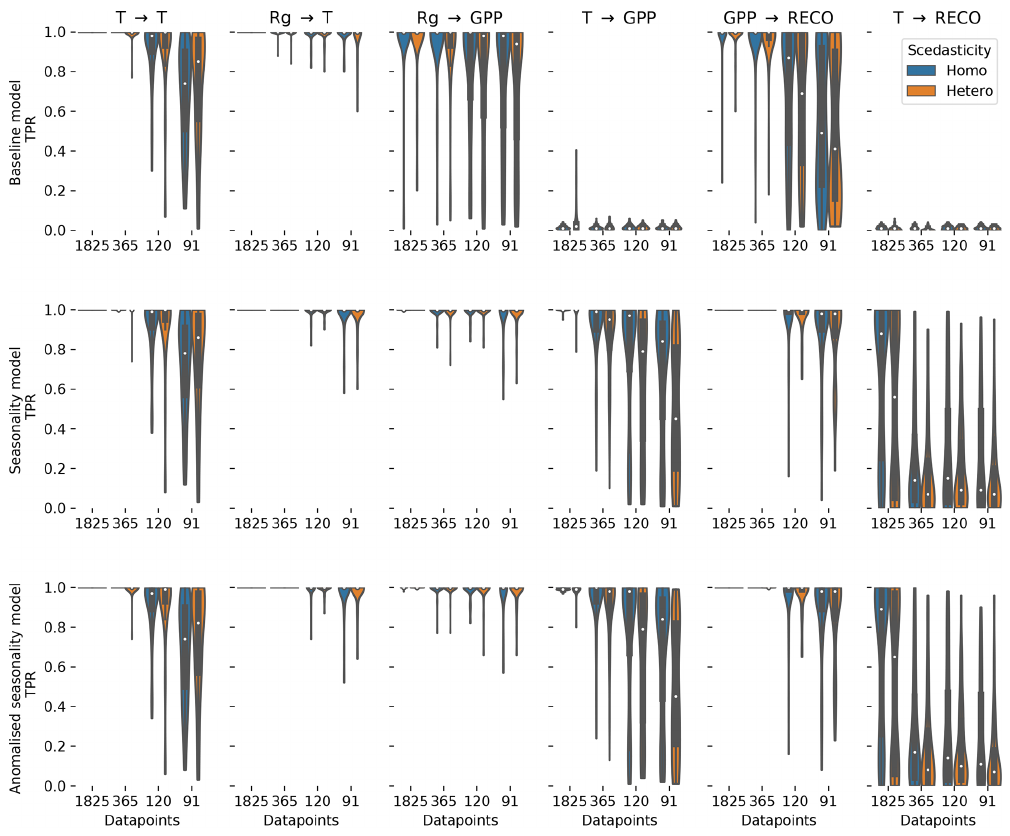
Figure 3. The distribution of the true positive detection rates for each link in the test model estimated for the baseline dataset, the season- ality dataset, and the anomalised seasonality dataset. The distributions are given for different time series lengths (number of datapoints). Additionally, the distributions are split to show the impact of heteroscedastic noise (orange) compared to normally distributed noise (blue).